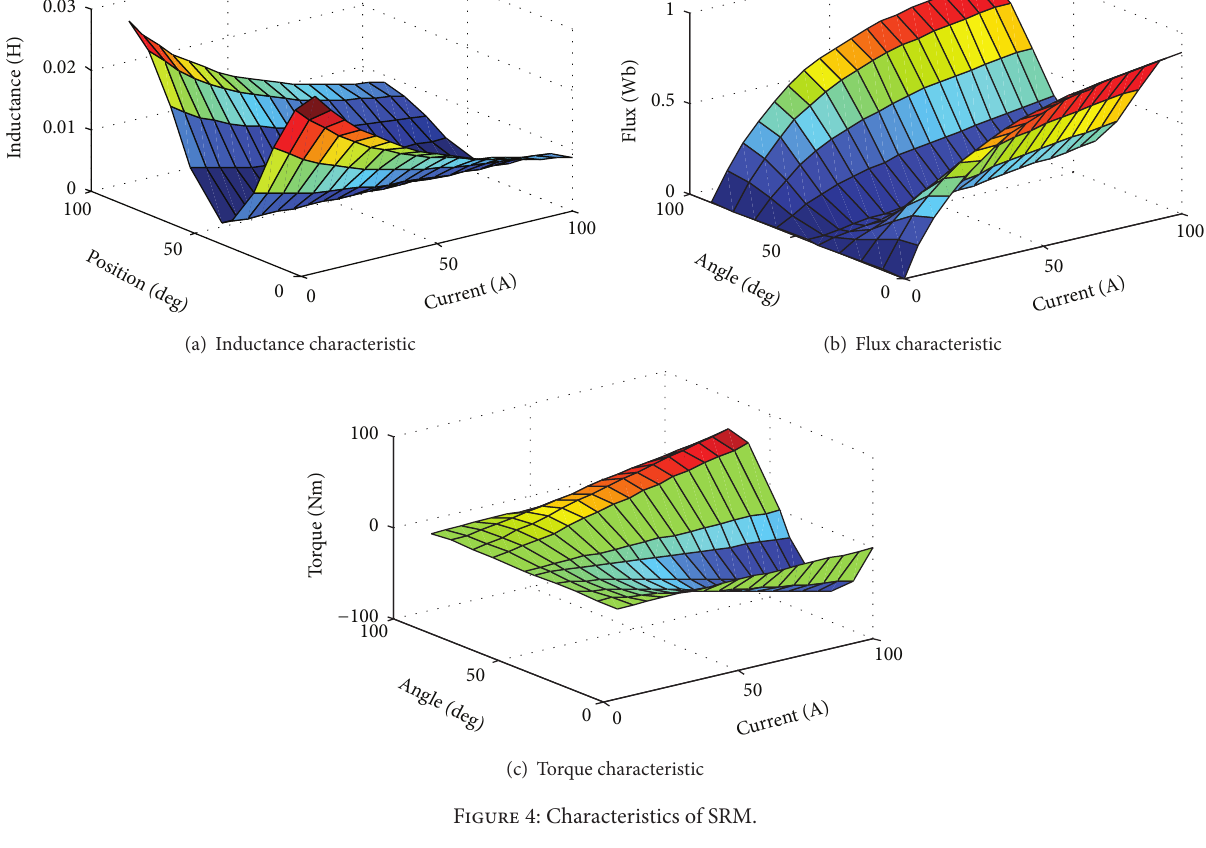
Figure 4: Characteristics of SRM.